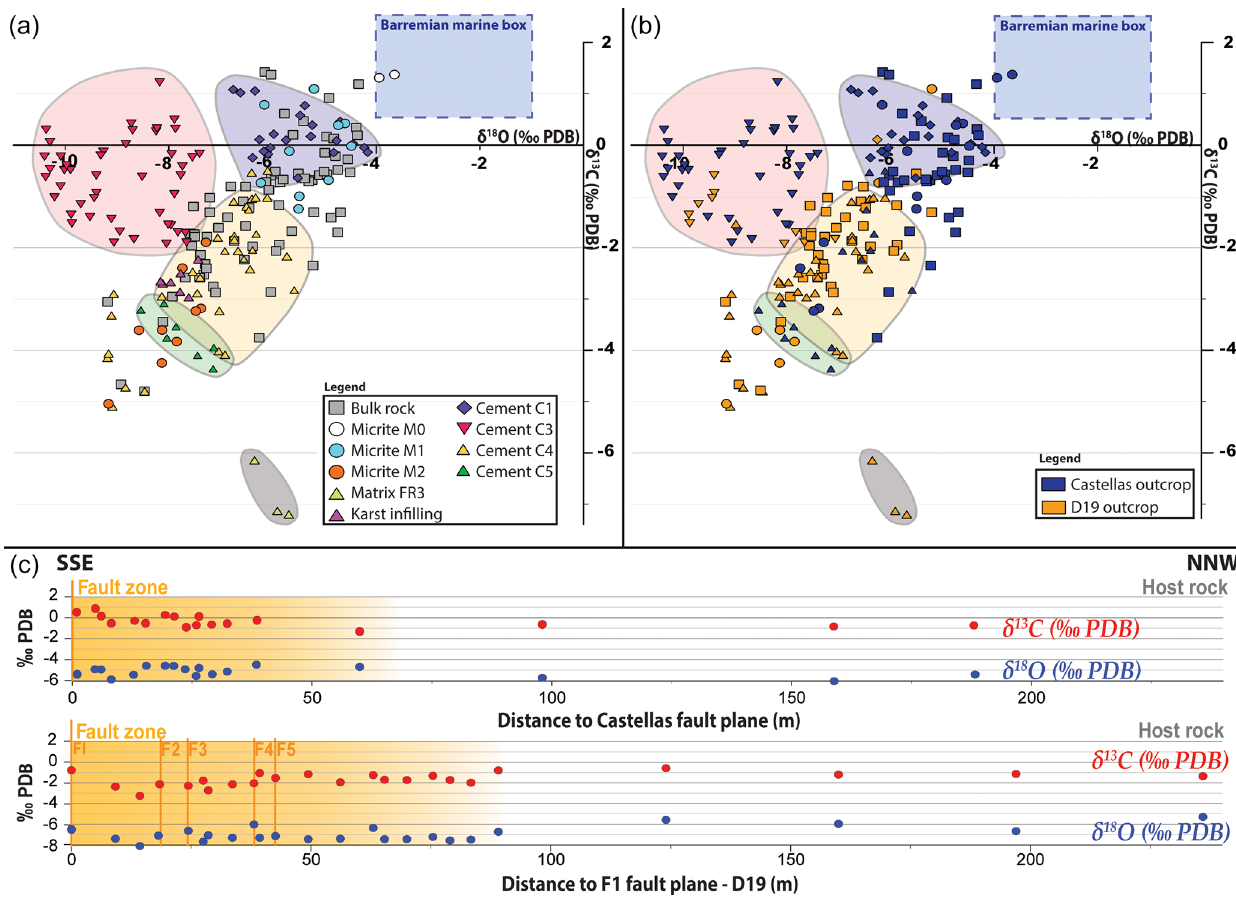
Figure 6. Isotopic values of δ 13 C and δ 18 O measured on bulk rock, cement phases, and micrite. Range values of “Urgonian marine box” from Moss and Tucker (1995) and Godet et al. (2006); (a) set of values sorted by the nature of diagenetic phases and (b) values sorted by the fault zone; (c) lateral evolution of δ 13 C and δ 18 O bulk isotopic values in Castellas (top) and in D19 (bottom) fault